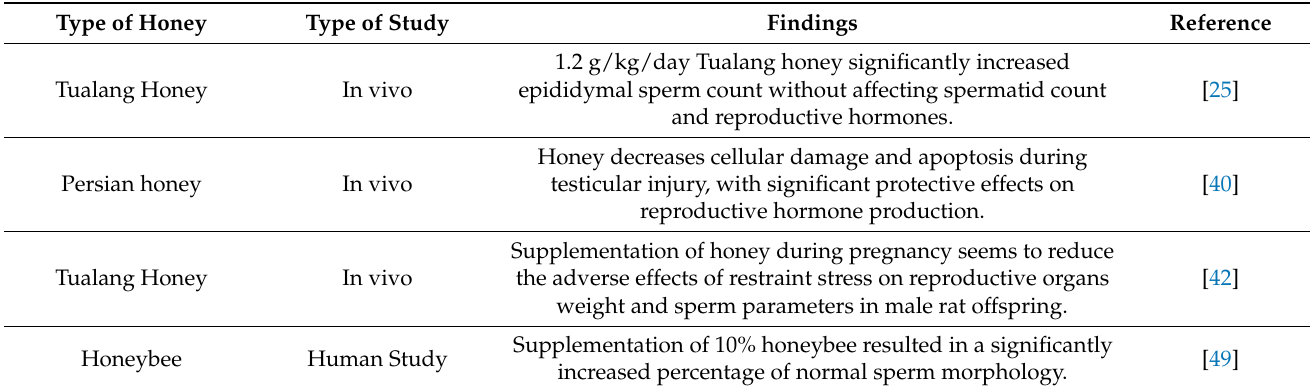
Table 1. Summary of the role of honey in improving male